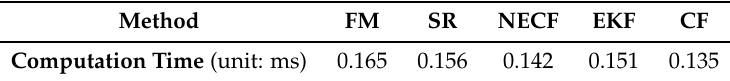
Table 5. Computation time for the considered methods.